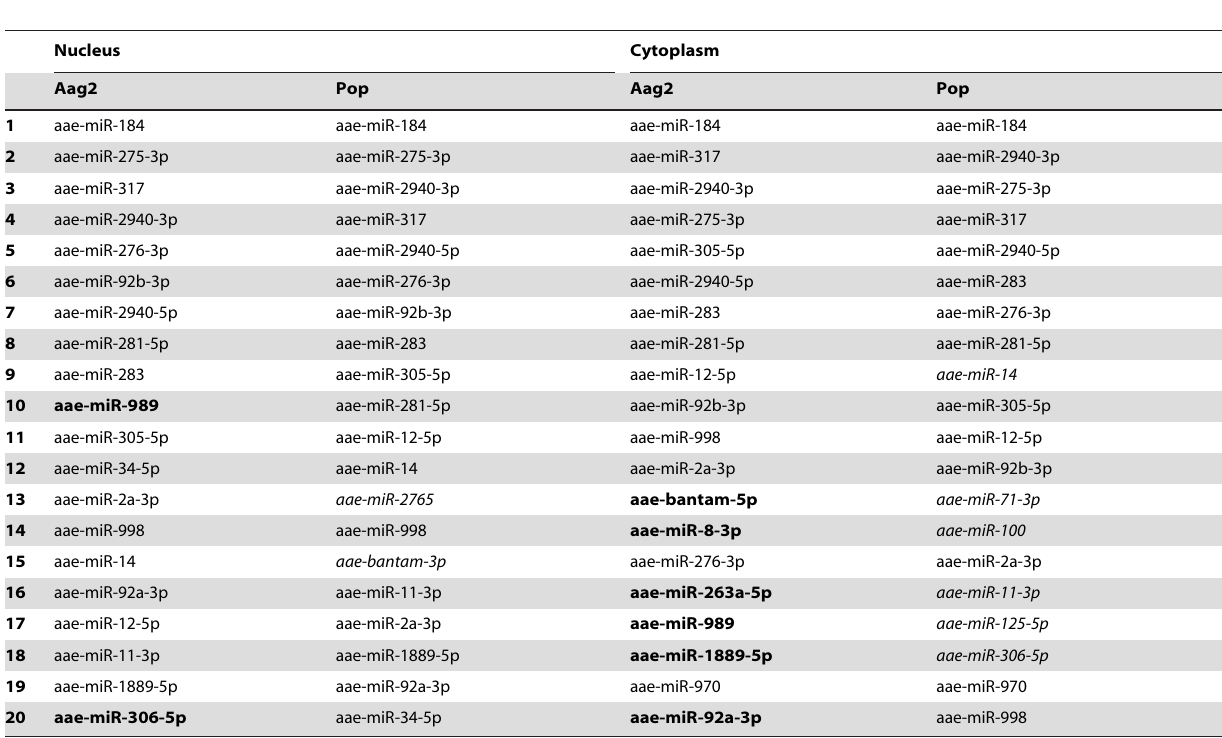
Table 1. Twenty most abundant miRNAs in the nucleus and the cytoplasm of Aag2 cells versus Wolbachia -infected cells (Pop).